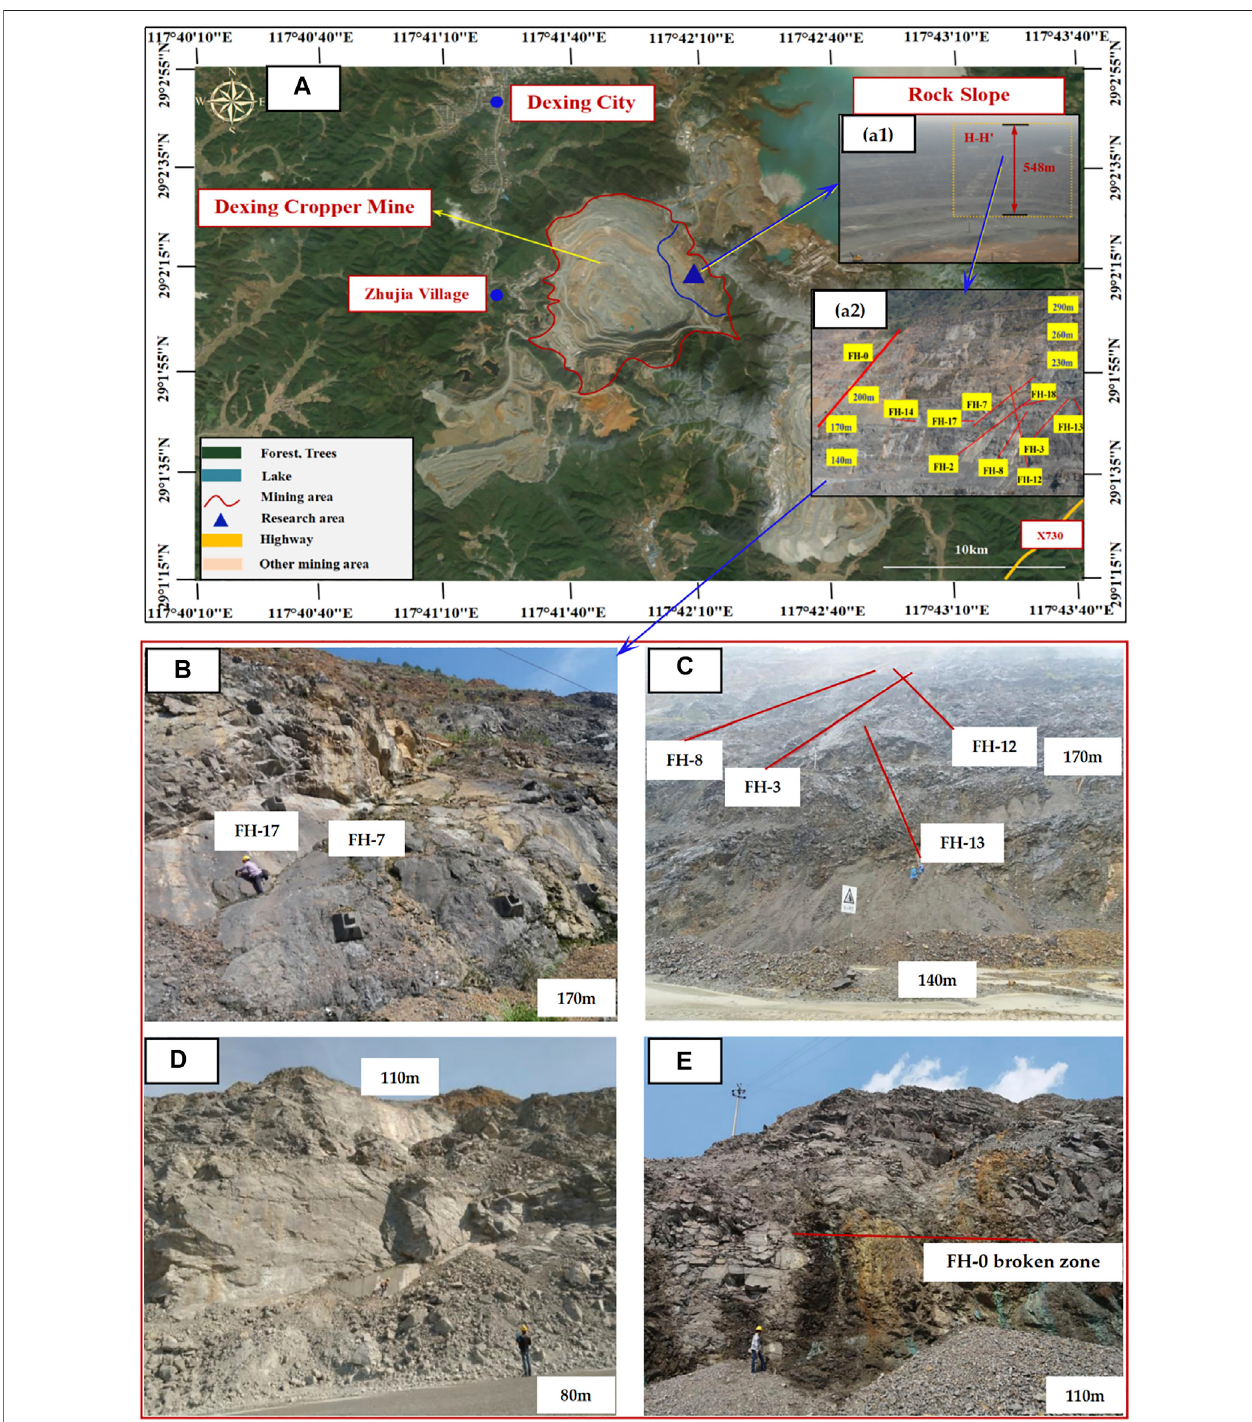
FIGURE1|(A) GeographicallocationandtopographicmapofDexingcoppermine; (B) faultofFH-7andFH-17; (C) faultofFH-3,FH-8,FH-12,andFH-13; (D) FH- 14 fault (the lower part is an 80-m platform, and the upper part is a 110-m platform); (E) FH-0 regional fault broken zone.